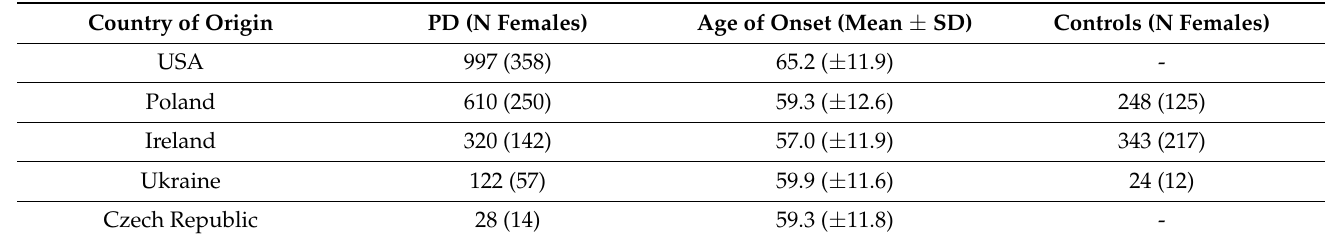
Table 2. Basic demographic characteristic of the population genotyped for CTSB c.851G > T (p.Gly284Val) variant.